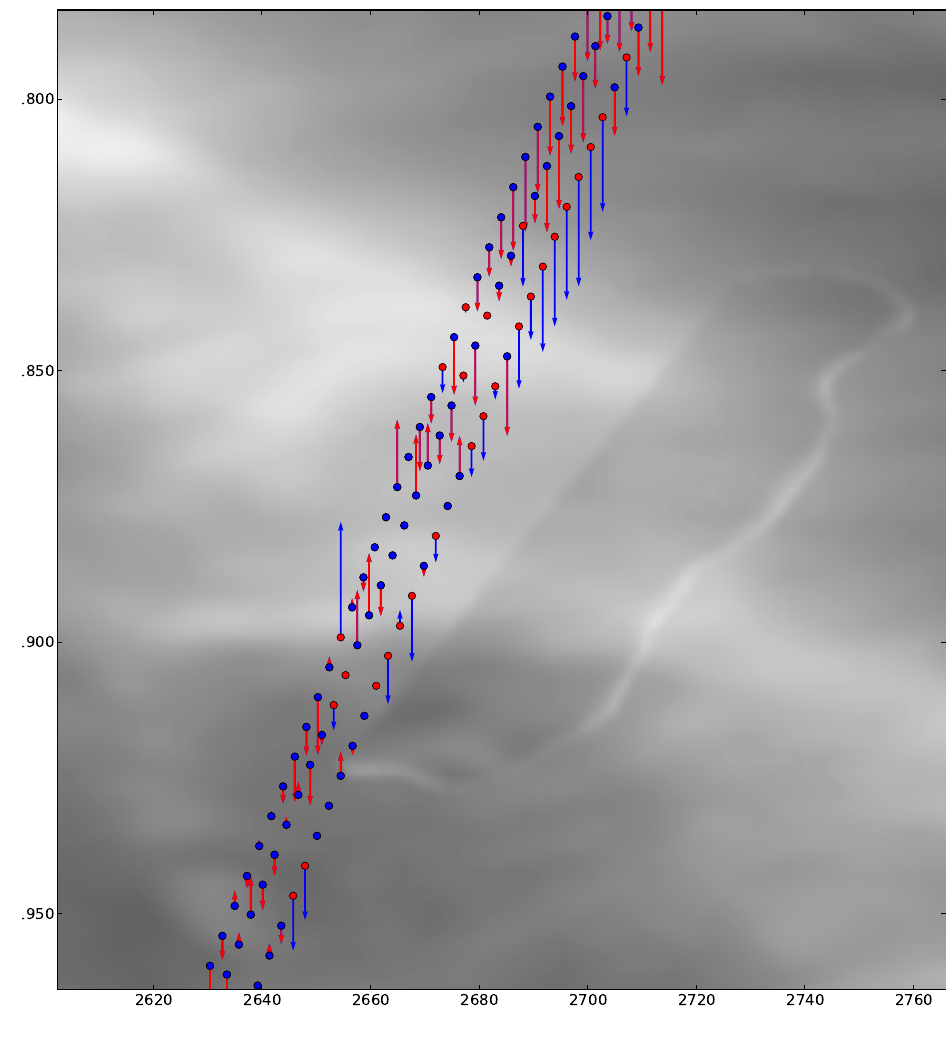
ICESat points located on the ASTER GDEM, corresponding to an area of 6 km × 5.1 km plus vector arrows showing the vertical errors of each point. Refined ICESat points to get points located only on the ground surface (red arrows) as well as eliminated points (blue arrows) are